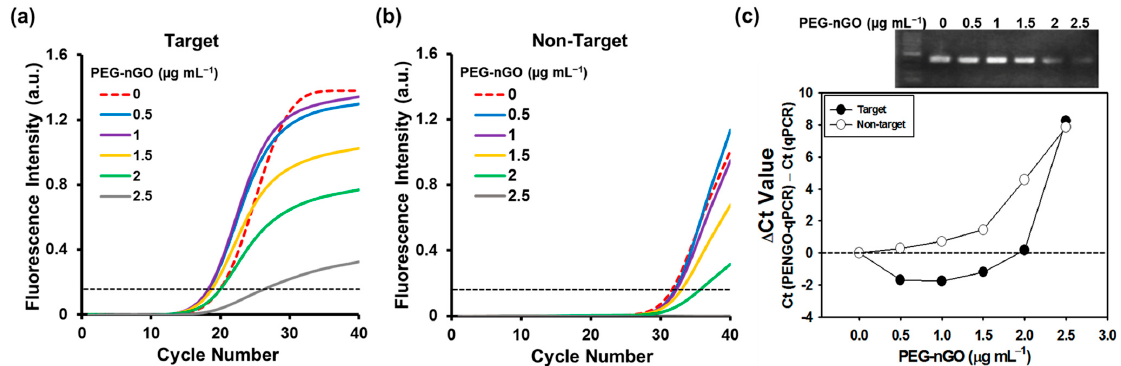
Figure 2. Effect of PEG-nGO concentration on EG-based qPCR. ( a ) Real-time fluorescence monitoring of qPCR-amplified products with target (IFZ B) RNA under various concentrations of PEG-nGO (0, 0.5, 1, 1.5, 2, and 2.5 μ g mL − 1 ). ( b ) Real-time fluorescence monitoring of qPCR-amplified products with non-target (IFZ A) RNA under various concentrations of PEG-nGO (0, 0.5, 1, 1.5, 2, and 2.5 µ g mL − 1 ). ( c ) Agarose gel electrophoretic analysis of qPCR-amplified products with target RNA under various concentrations of PEG-nGO (0, 0.5, 1, 1.5, 2, and 2.5 µ g mL − 1 ) (top panel). ∆ Ct values of qPCR- amplified products with target and non-target RNA under various concentrations of PEG-nGO (0, 0.5, 1, 1.5, 2, and 2.5 µ g mL − 1 ). ∆ Ct values were plotted as the difference between Ct values